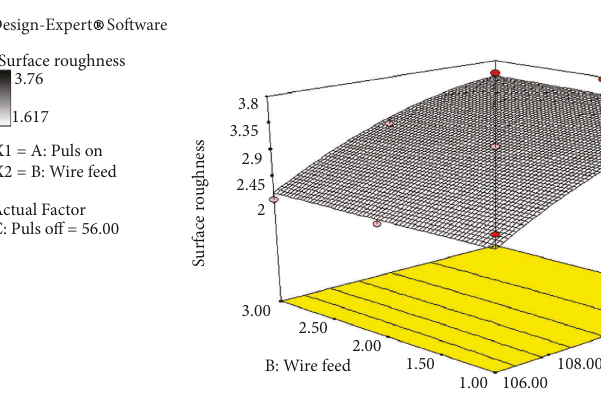
Figure 13: Effect on the PT